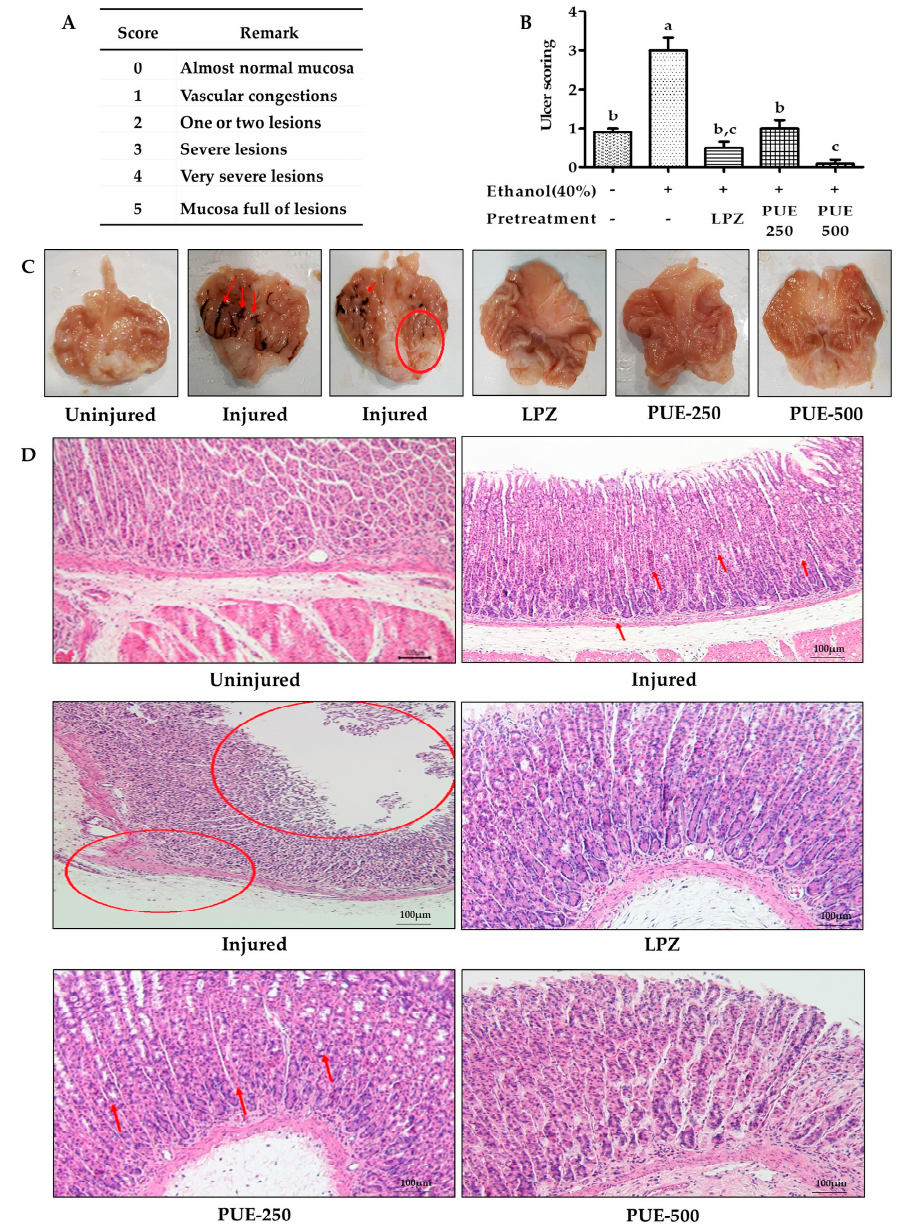
Figure 5. Effects of PUE on ulcer scoring and gastric mucosa histology. ( A ) The Guth standards for gastric ulcer scoring include a physical description of gastric gross anatomy; ( B ) ulcer score variation among different groups of rats, as ethanol induces UI effects in the injured group, was attenuated in PUE (PUE-250 and PUE-500) pretreated groups in a dose- dependent manner; ( C ) gross anatomy of gastric mucosa for different groups of rats including the uninjured group without lesions and injured group with hemorrhagic (as indicated by red arrows) lesions (as indicated by circles); the LPZ (30 mg/kg of lansoprazole) group with smooth mucosal lining, and PUE-250 (250 mg/kg of PUE) and PUE-500 (500 mg/kg of PUE) groups without injury, but with slight congestion of the mucosa; and ( D ) gastric mucosal histology: uninjured group had a smooth gastric mucosal anatomy with normal morphology and color of the parietal cells with distinct cellular structure, glandular pits, and an absence of infiltration; the injured group with cellular degeneration (as indicated by red arrows), mucosal atrophy (as indicated by circles), discoloration of parietal cells depicting the existence of cytoplasmic mucin with hyper-chromatic cells; LPZ, PUE-250, and PUE-500 with mild to moderate degeneration of cells and normal parietal cell coloration (HE staining × 100). The graphical result is presented as means ± SEM for each group and values with different letters indicate significant differences ( p <